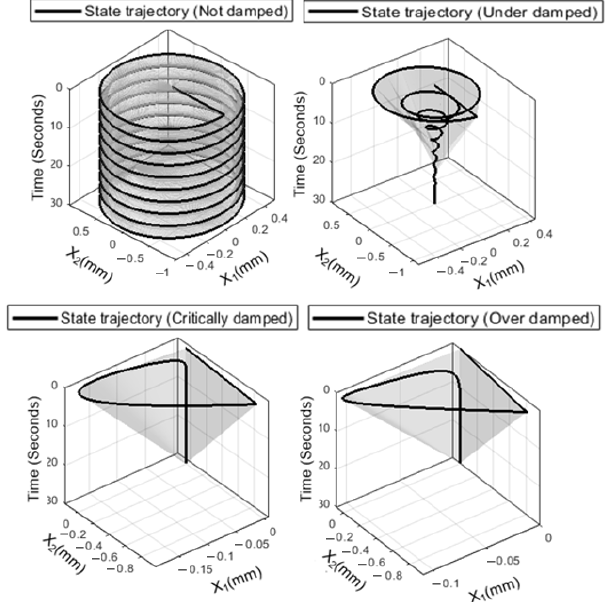
Figure 13. System phase portrait (domain of attraction) 3D representation as an indicator of engi- neering resilience. The vertical axis indicates settling time for a unit impulse input and [0, 0] initial conditions (Case example 1).